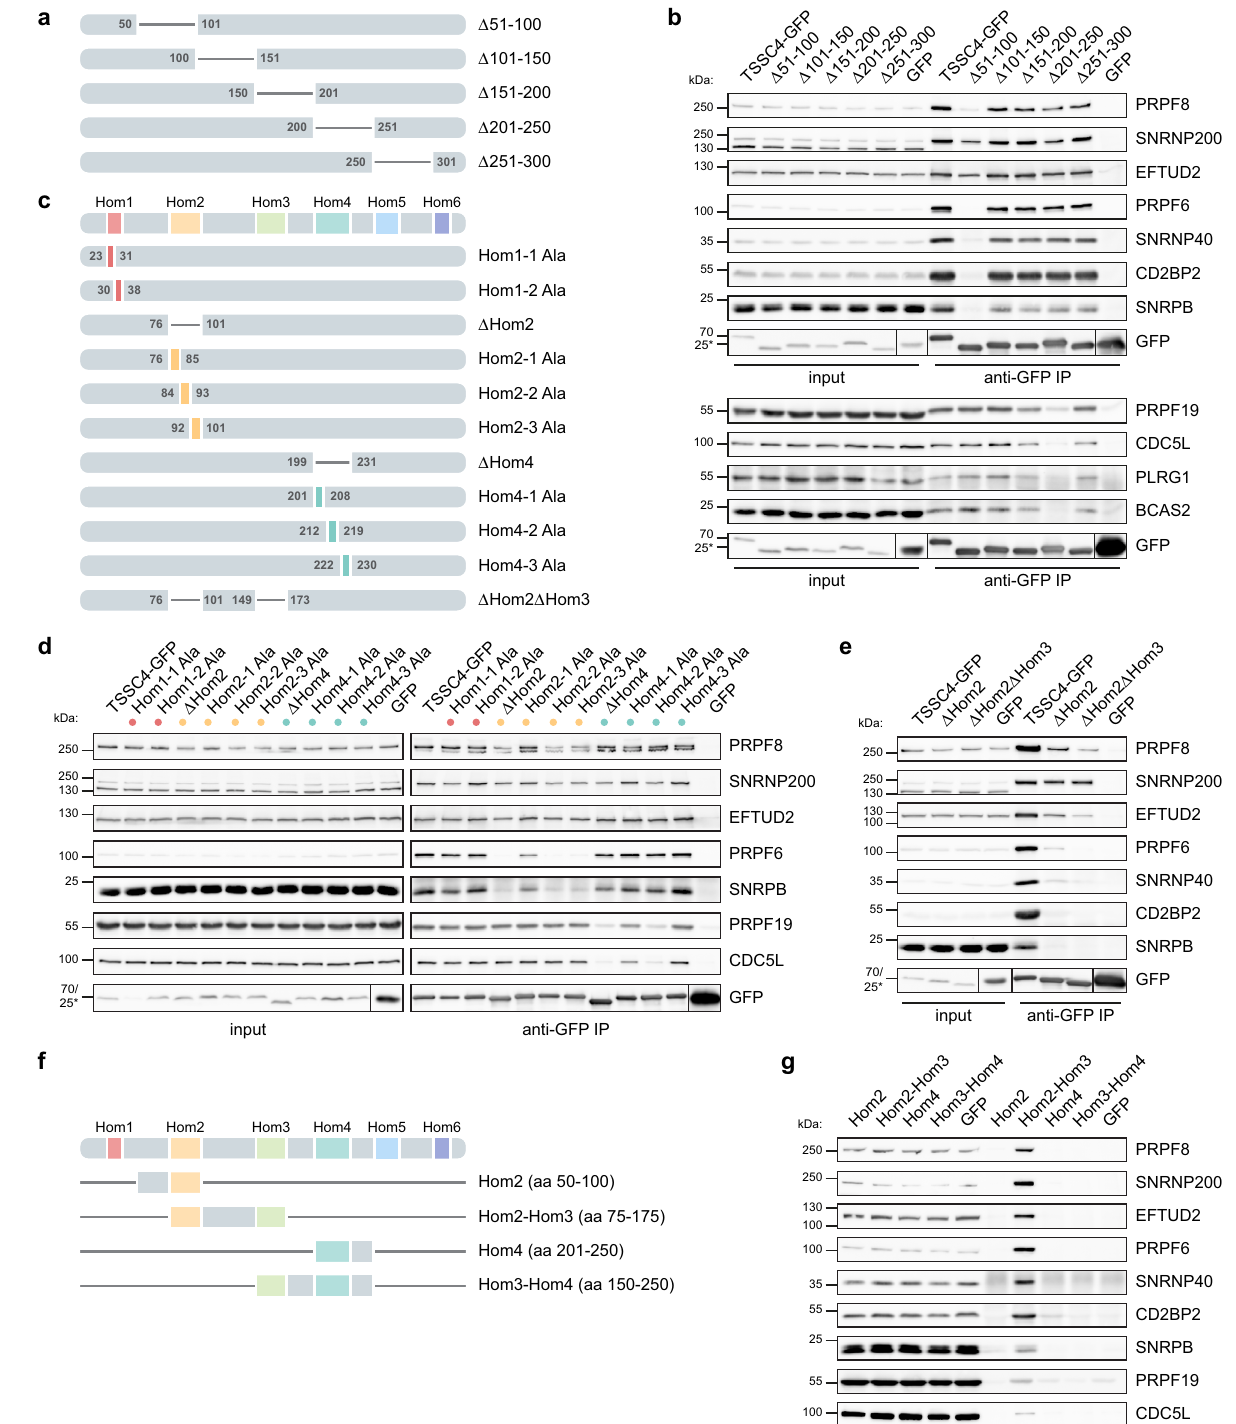
analysis of TSSC4 ordered/disordered regions (Supplementary Fig. 2d) using MetaDisorderMD2 42,43 . This analysis predicted that most TSSC4 sequence is largely disordered with a few exceptions involving the central part of the molecule spanning Hom3 and 4 domains, which shows a weak tendency for ordered structures.